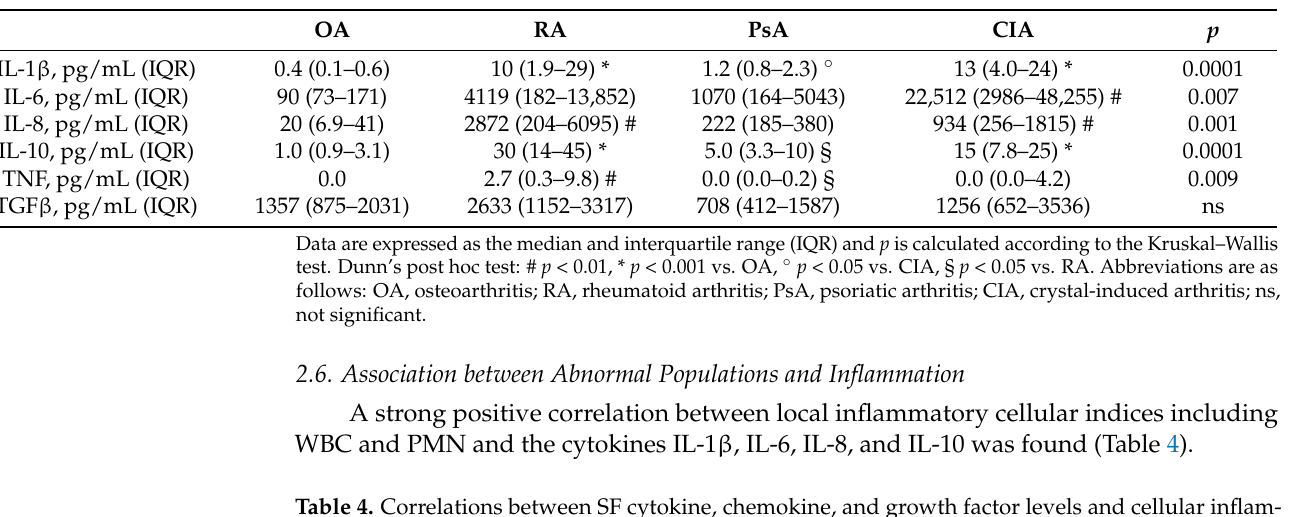
Table 3. Cytokine, chemokine, and growth factor levels in SFs from OA (n = 7), RA (n = 6), PsA (n = 12), and CIA patients (n = 10).